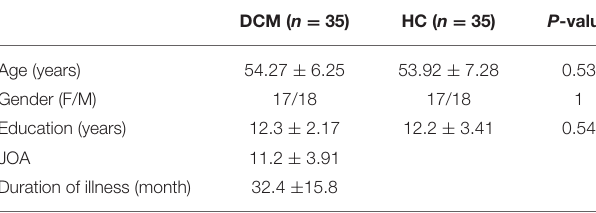
TABLE 1 | Demographic data of the two